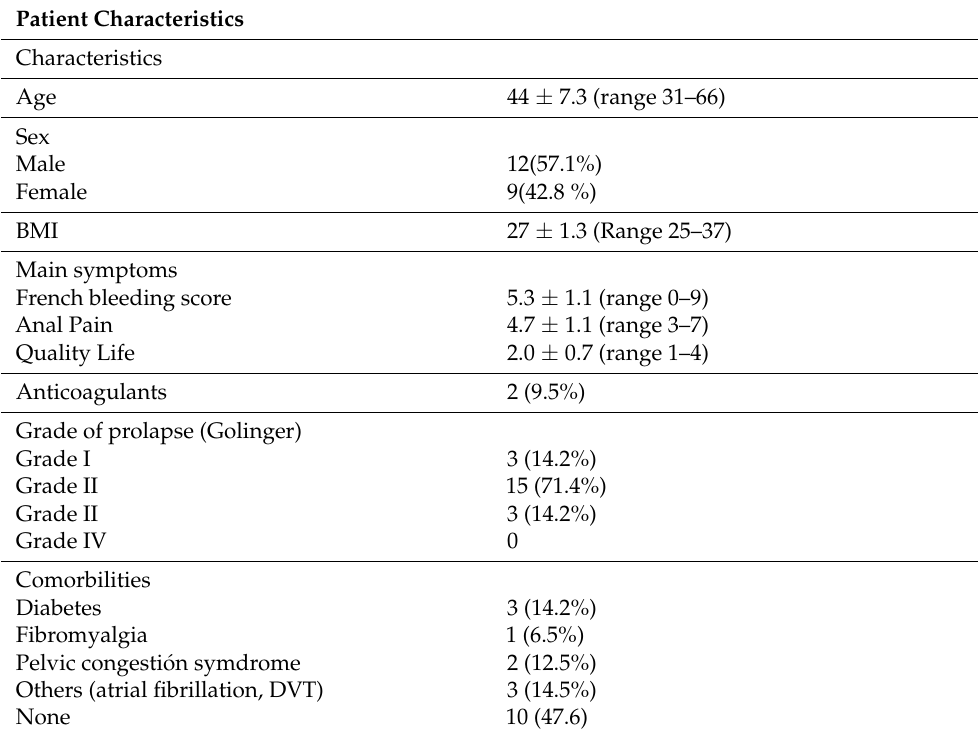
Table 1. Months in relation to bleeding (FBS), pain measured using VAS and quality of life (QOL). Patient